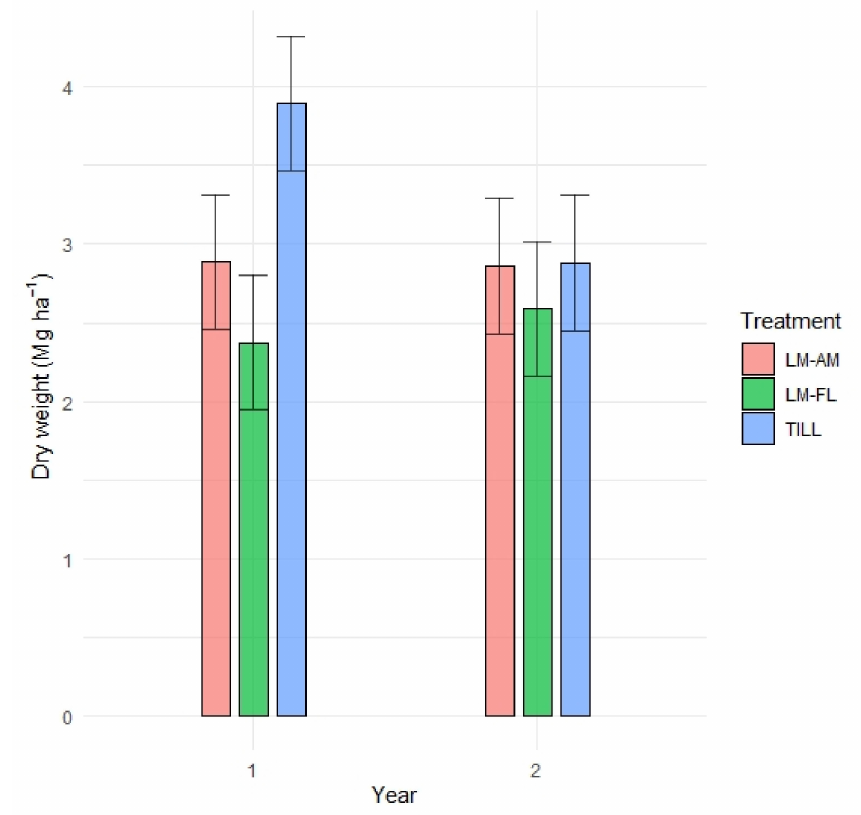
Figure 2. Effect of treatments (TILL, LM-FL, LM-AM) and years (1 is 2019, 2 is 2020) on cauliflower plants’ dry weight (stems and leaves). Error bar represents the upper and lower limits of the 95% confidence